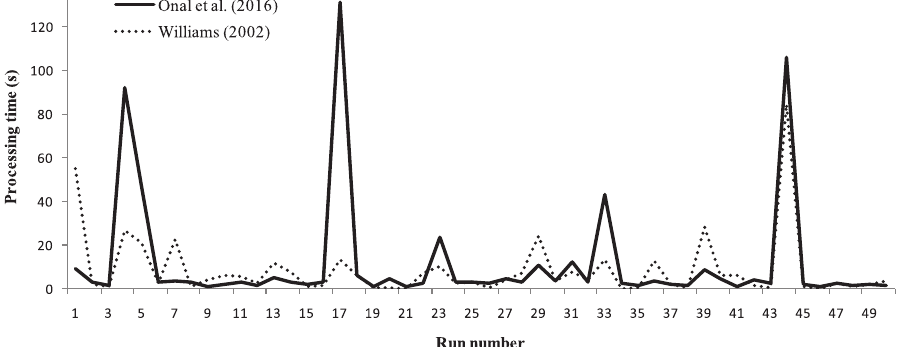
Figure 3. Computational efficiency of the Önal et al. (2016) and Williams (2002) models in solving a 100-site problem with various species distributions and site costs